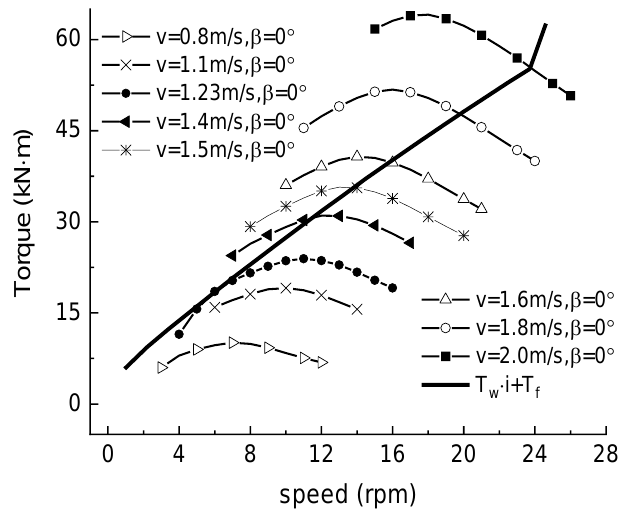
Figure 7. Comparison of torque characteristics between the generator and impeller.